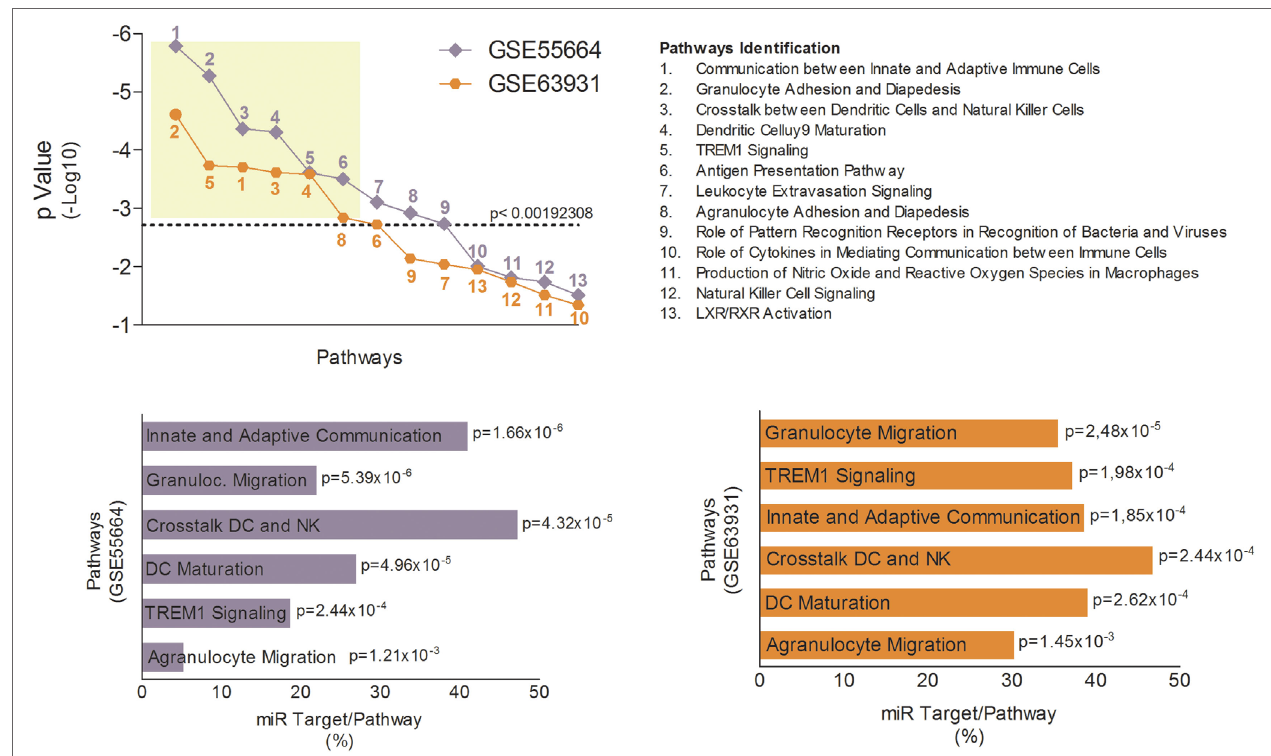
FigUre 3 | Canonical pathways associated with innate immune response identified in localized cutaneous leishmaniasis (LCL). (a) p -Value of 13 canonical pathways common to both data sets, GSE55664 (purple) and GSE63931 (orange), and related to the innate immune response. Each symbol represents one pathway identified by numbers and listed on the right. The most significant pathways in GSE66554 (B) and GSE63931 (c) are identified by p -value and percentage of molecules that are targets for LCL